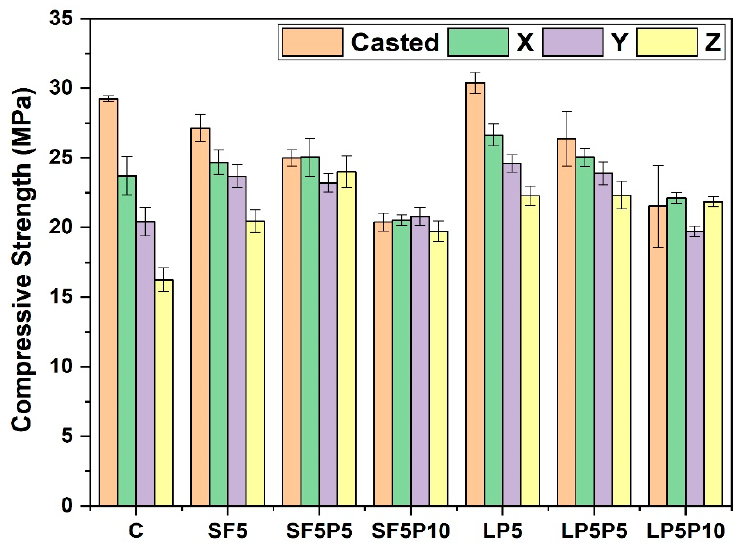
Figure 12. 28-day Compressive strength of cast and printed specimens with and without PCM.